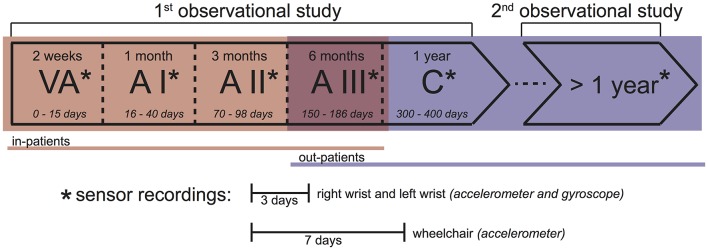
Measurement protocol. This study consists of two observational studies. In the 1st observational study, patients were measured at 5 time points during the rehabilitation process. In the 2nd observational study, a different patient cohort was measured only once, at least 1 year after injury. In stages VA, A I, A II, and partly A III of the 1st observational study, patients were in-patients (red). In the 2nd observational study, as well as partly in A III, and stage C of the 1st observational study, patients were out-patients (blue). At each time point (*), acceleration and angular velocity of the right and left wrists were recorded for 3 days, while the acceleration of the right wheel of the wheelchair was recorded for 7 days. Overall upper limb activity (AC) and PA based on energy expenditure (SED, LPA, and MVPA) were calculated based on the 3 day recordings. All wheeling-related measures (DISTTOT, DISTACT, and VEL) were calculated based on the 7 day recordings.